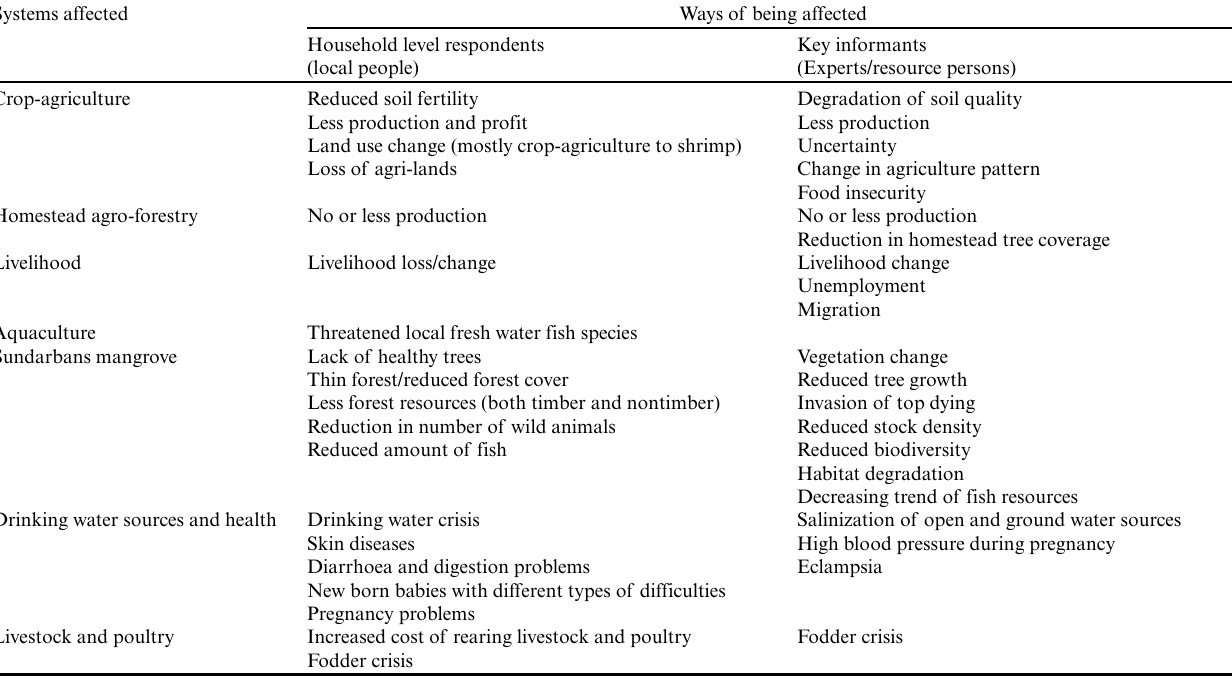
Table 4 . Observed effects of salinity increase by different categories of